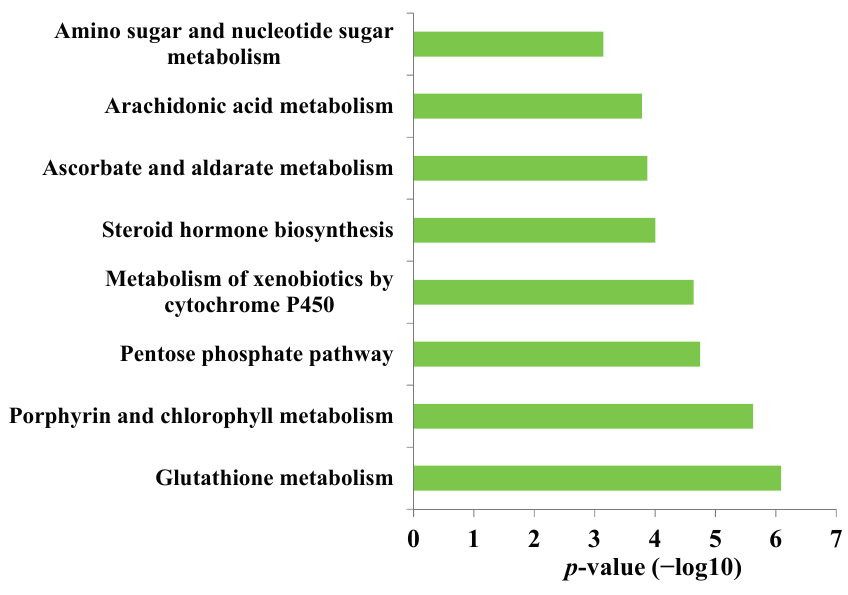
Figure 2. The enriched KEGG function of module 27 of cMap-Si-Wu-Tang dataset, with p -values adjusted by False Discovery Rate calculation using Benjamini-Hochberg method